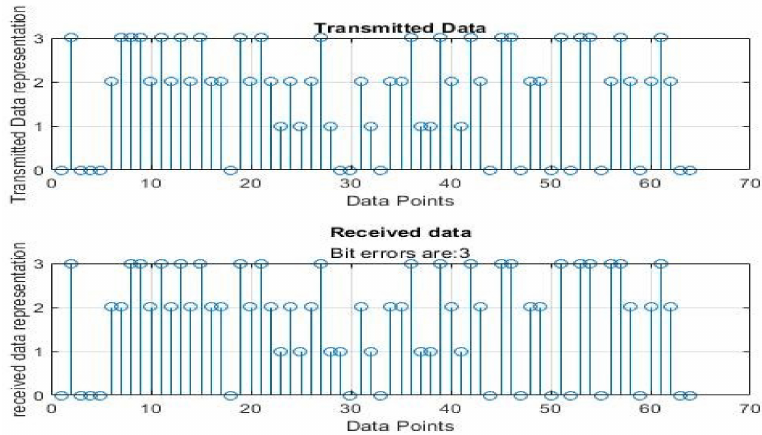
Figure 5. Customary QPSK output for 64 data points in a noiseless channel.